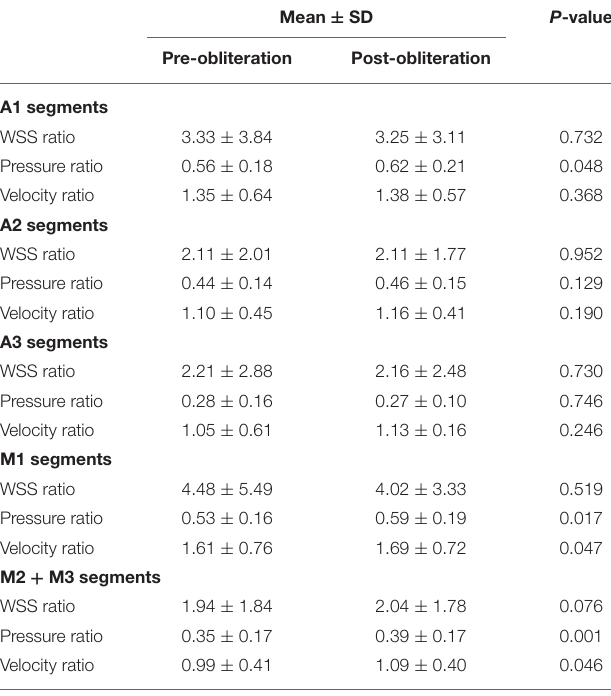
TABLE 2 | Hemodynamic changes in the distal arteries after obliteration of aneurysms. Mean ± SD P